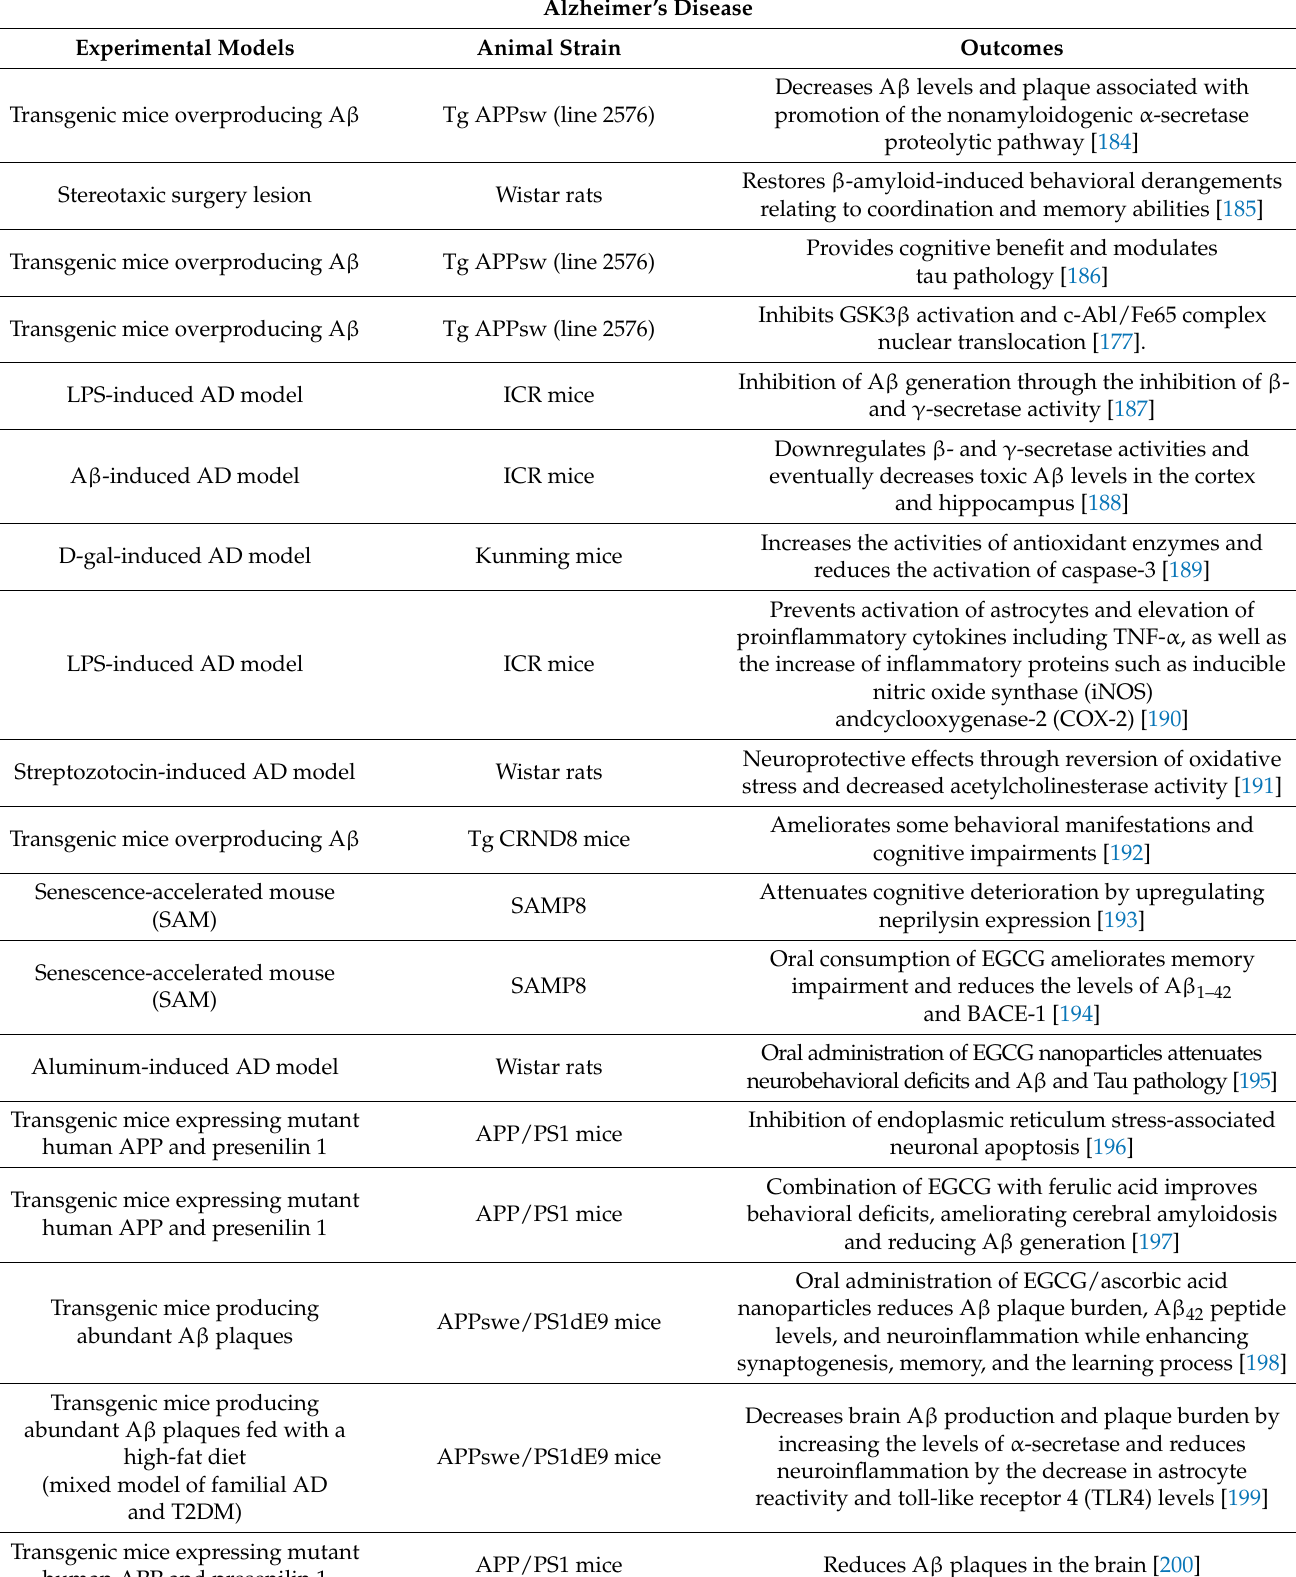
Table 3. Main evidence of the neuroprotective effects of EGCG in animal